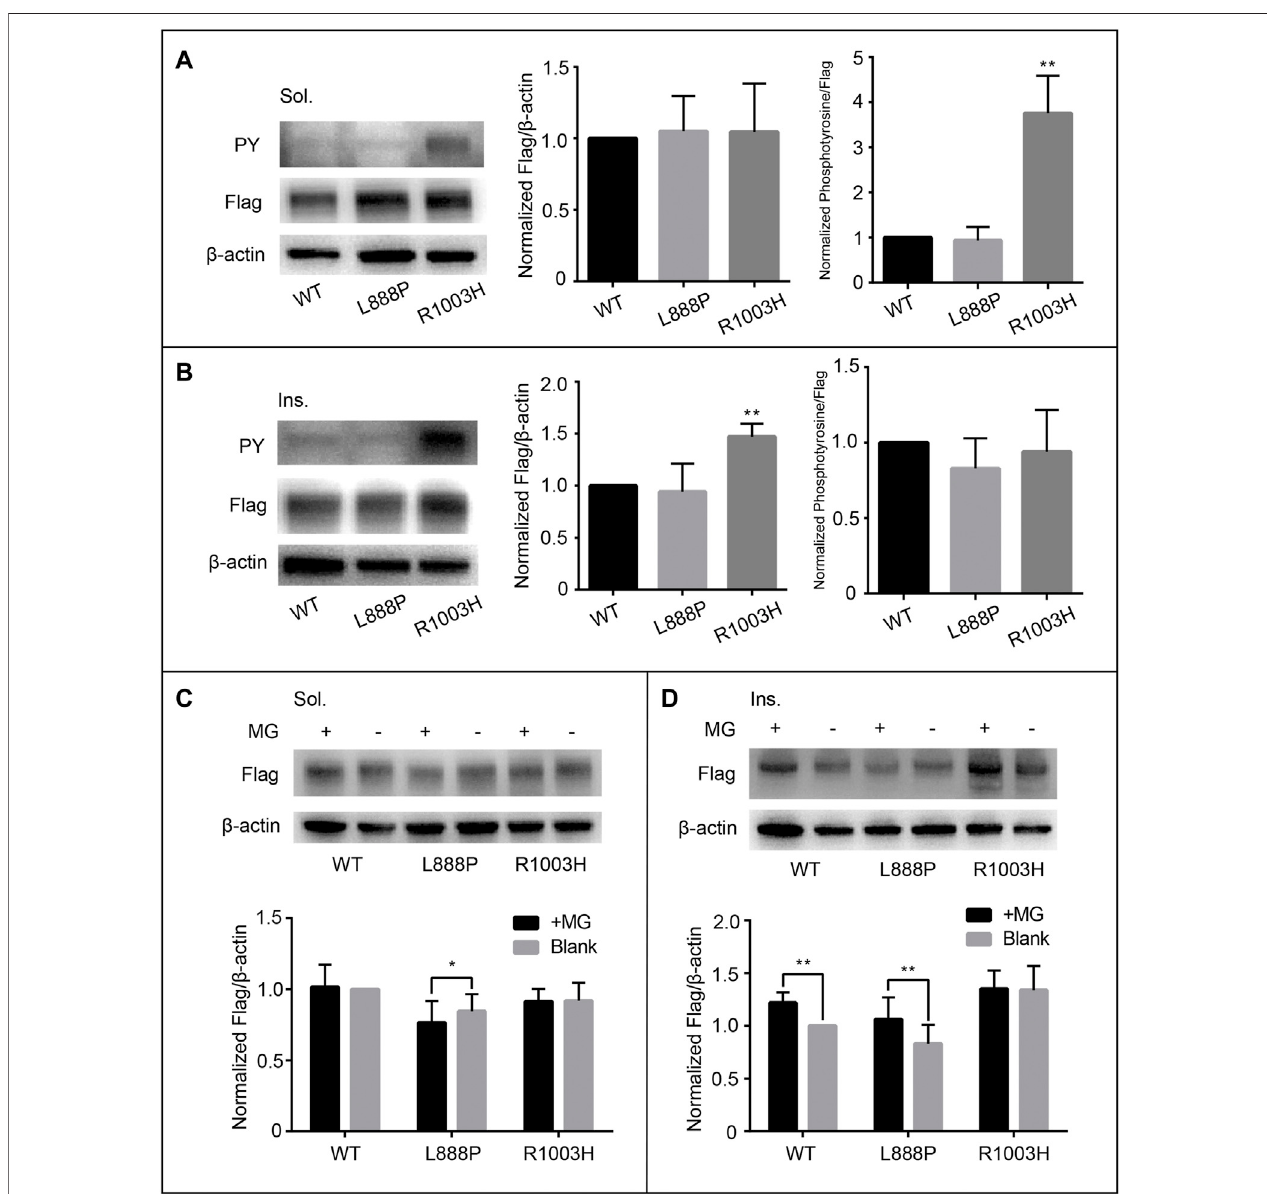
FIGURE 3 | Functional assessment of cytodomain variants p.L888P and p.R1003H. The protein expression and auto-phosphorylation levels of p.L888P are comparable to that of wild type (A , B) . However, p.R1003H is signi fi cantly phosphorylated in soluble portion (A) and enriched in insoluble fraction (B) , which does not respond to MG132 treatment (C, D) . Sol, soluble; Ins, insoluble; PY, phosphotyrosine; WT, wild type; MG,